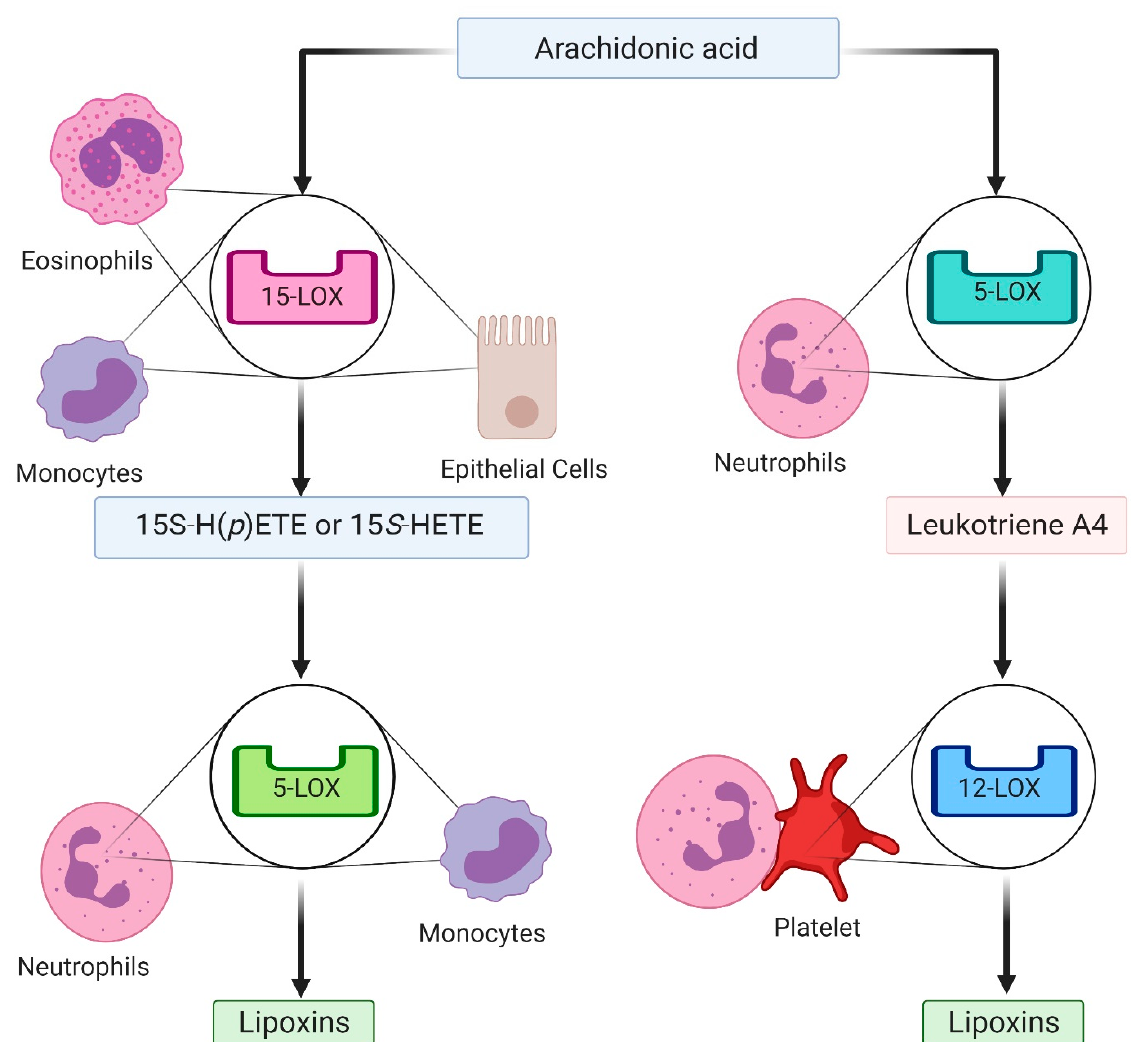
Figure 1. Arachidonic acid-derived specialized pro-resolving mediator synthesis. Synthesis of the specialized pro-resolving mediator, lipoxin, requires transcellular biosynthesis (left side). Arachidonic acid receives an oxygen from 15-lipoxygenase (LOX), generating either 15 S -hydroperoxyeicosatetraenoic acid (15 S -H( p )ETE) or 15 S -hydroxyeicosatetraenoic acid (15 S -HETE). These metabolites are taken up by neutrophils where 5-LOX generates 5,6-epoxytetraene, an unstable molecule which is hydrolysed into lipoxins. Arachidonic acid can also be metabolized by neutrophils into leukotriene A4 (right side). Upon neutrophil ‐ platelet binding, leukotriene A4 is converted into lipoxins by platelet 12 ‐ LOX.